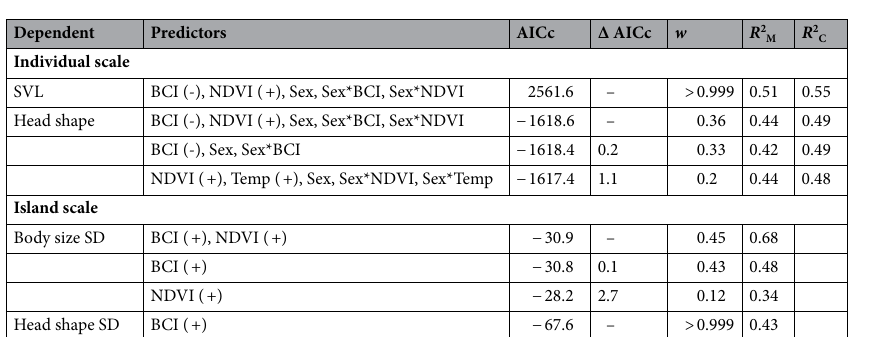
Figure 3. Conditional plots showing the relationship between sexual dimorphism and the environmental drivers included in the best AICc models at the individual scale (N = 408). Phenotypic traits: ( a , b ) SVL, ( c , d ) head shape; drivers: interactions between ( a , c ) sex and BCI and ( b , d ) sex and NDVI. Male–female differences are divided in three categories of environmental drivers: low (10th quantile), intermediate (median), and high (90th quantile) of BCI ( a , c ) and NDVI ( b , d ).